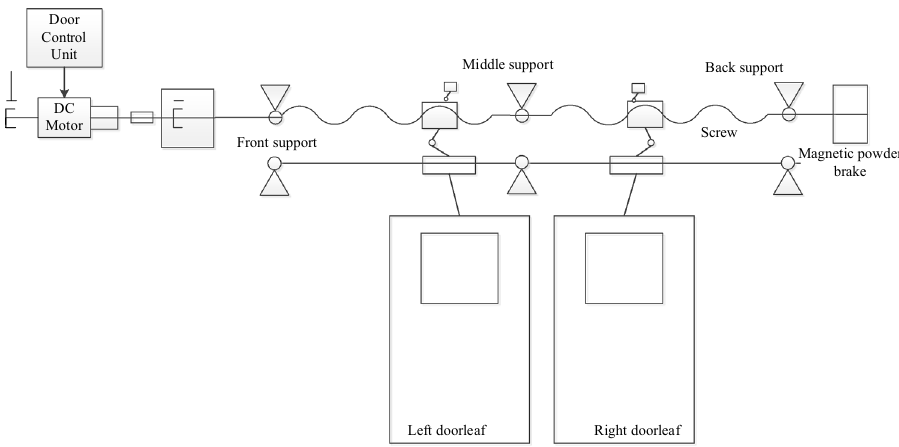
Fig. 8 Magnetic powder brake